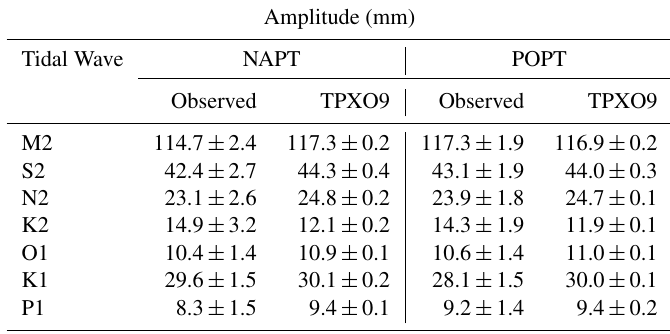
Table 2. Observed and predicted by TPX09_v2a model amplitudes of the main seven tidal components for NAPT and POPT.